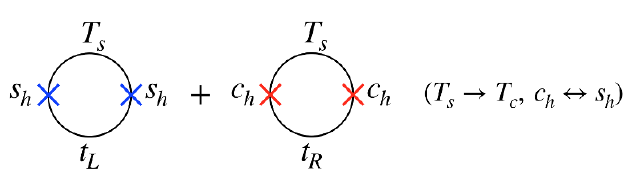
Figure 4 . Naturalness condition by left-right Z 2 symmetry, which is realized if the parity between the left-handed sector and right-handed sector is assigned. Quadratic divergence is cancelled as V ( h ) (cid:24) (cid:3) 2 (cid:1) ( s 2 + c 2 h h